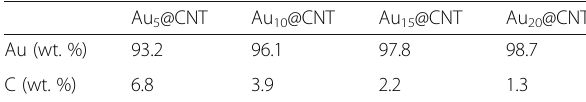
Table 1 Mass content of Au and C in Au x @CNT sheet